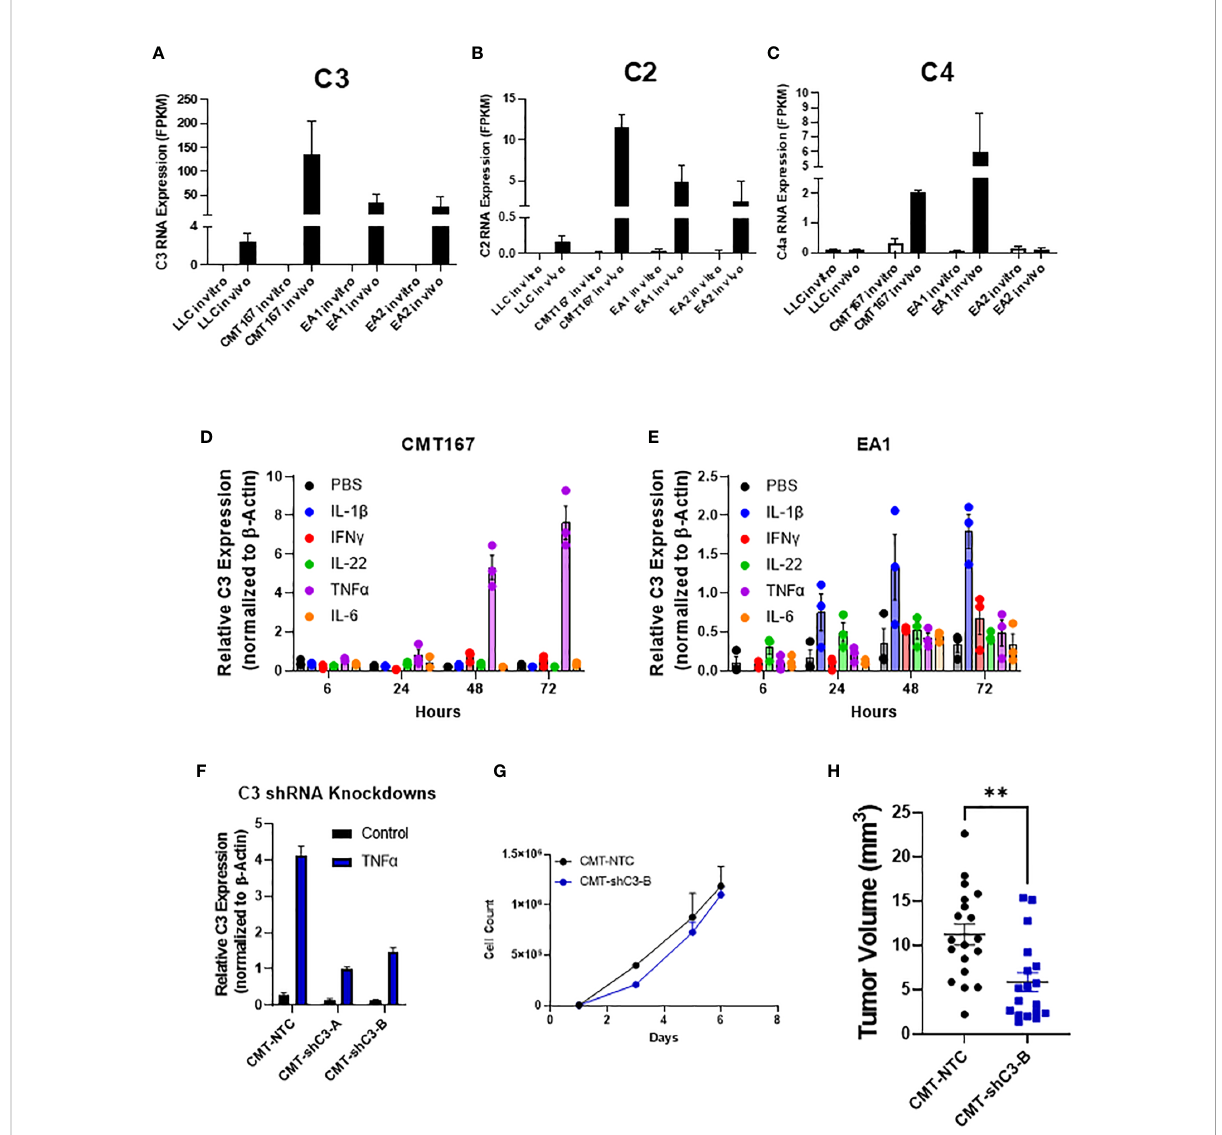
FIGURE 4 Role of C3 in tumor promotion FPKM values for C3 (A) , C2 (B) , and C4 (C) from our RNA-seq experiment show an induction of complement components C2 and C3 in vivo in 4 cell lines, with CMT and EA1 having an increase in C4 expression in vivo compared to in vitro samples. In vitro , CMT167 (D) and EA1 (E) cells were stimulated with IL1 b (10 ng/mL), IFN g (10 ng/mL), IL-22 (100 pg/mL), TNF a (10 ng/mL), IL-6 (100 pg/ mL), or control (PBS) for 6, 24, 48, and 72 hours. RNA was isolated from the samples and qPCR was performed to determine what cytokines cause the induction of C3. Data were normalized to the expression of b -actin. (F) CMT167 cells were infected with C3 shRNA lentiviruses to knockdown down C3 expression. To con fi rm knockdown, cells were treated 10 ng/mL TNF a for 48 hours, RNA isolated, and qPCR performed to con fi rm knockdown in unselected, pooled samples. (G) Equal numbers of CMT-NTC or CMT-shC3-B cells were plated and proliferation was measured in the presence of TNF a over a 6 day period by quantifying cell number (H) 250K CMT-NTC or CMT-shC3-B cells were implanted into the left lung of C57Bl/6 mice, and established for 2 weeks before tumors were harvested and measured via digital calipers. Graph is combined of 2 independent experiments. N=9-11 per group per experiment. 2 outliers were removed using the ROUT test where Q=1%; a nonparametric Mann-Whitney was performed;